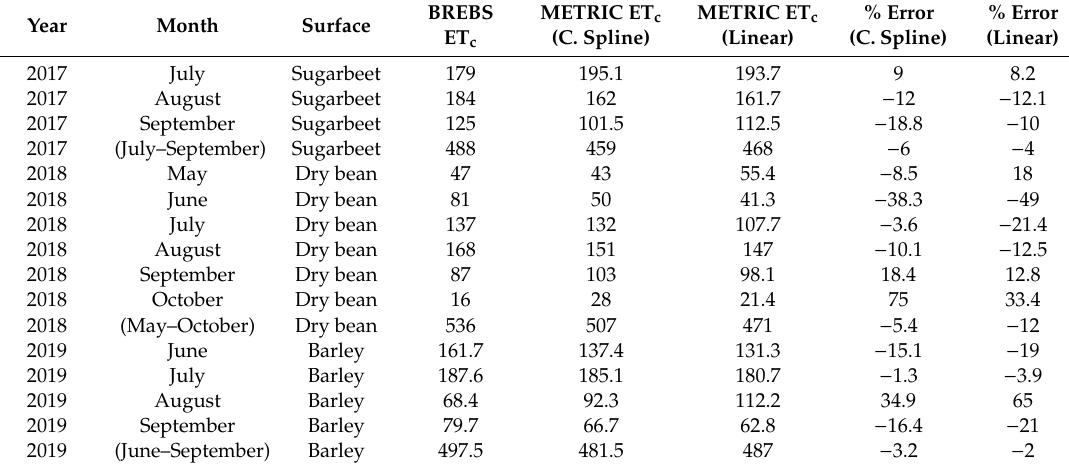
Figure 7. Comparison of METRIC estimated and BREBS station measured monthly ETc (mm) during 2017, 2018, 2019, and pooled data from all the growing seasons. ( a ) Linear Interpolation, ( b ) Cubic spline interpolation. Table 3. Statistical comparison between METRIC estimated (via linear and cubic spline interpolation) and BREBS derived monthly and seasonal ETc during 2017, 2018, and 2019 growing